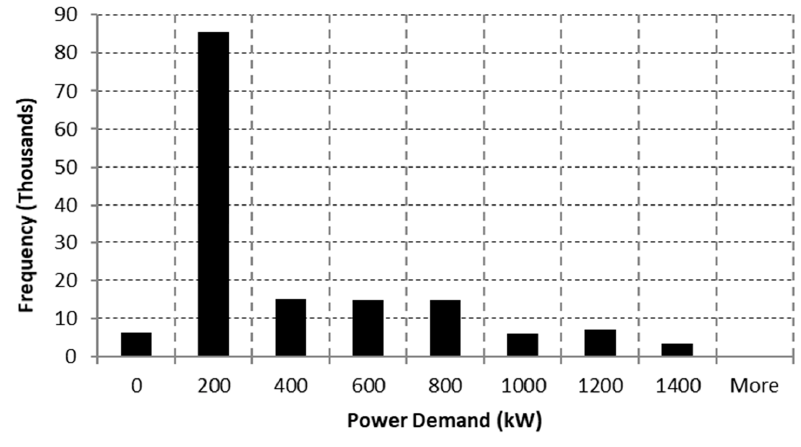
Figure 7. Histogram of power demand.